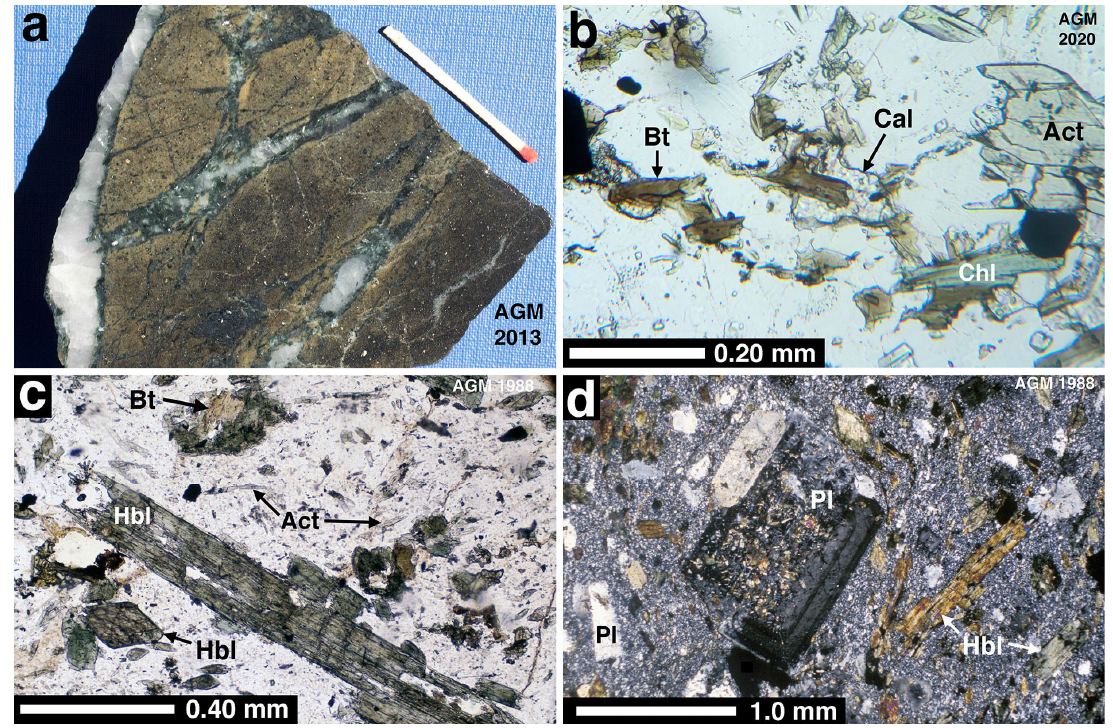
Figure 10. Photographs and photomicrographs of the second albite-actinolite altered dyke (a–b; sample HB-8b in Figure 4) and of least-altered quartz monzodiorite or diorite porphyry 750 m northeast of New Celebration (c–d; UWA no. 59072). ( a ) Zoned quartz-actinolite veins and fractures lined with green actinolite, calcite, and titanite crosscut an aphanitic albite groundmass containing pyrite (5 vol.%), biotite (1%), rutile and hematite (0.5%). The matchstick is 43 mm long. ( b ) Actinolite (Act), biotite (Bt), and Mg-Fe chlorite (Chl) in contact with calcite (Cal) and opaque pyrite in albite-rich groundmass. Plane polarized light. ( c ) Igneous green hornblende pheno- and glomerocrysts (Hbl), locally rimmed by brown biotite (Bt), in a feldspar ± quartz groundmass containing acicular actinolite (Act). Plane polarized light. ( d ) Igneous hornblende phenocrysts (Hbl) and plagioclase pheno- and glomerocrysts (Pl), some with oscillatory compositional zones partly replaced by clinozoisite and sericite. Crossed polarized light.